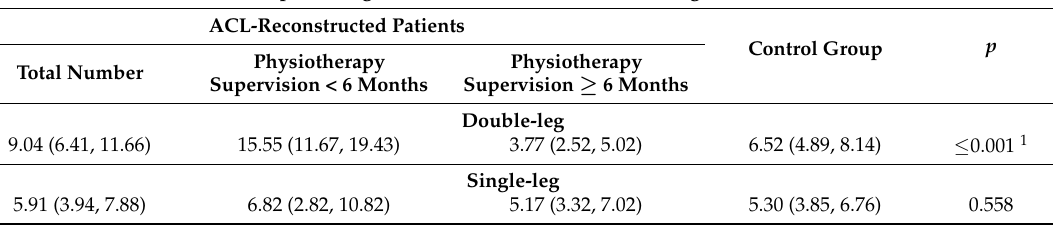
Table 4. Between-group comparison of vertical ground reaction force between-limb percentage difference values obtained during the double-leg and single-leg vertical hop landing in patients with postoperative physiotherapy supervision < 6 months, patients with postoperative physiotherapy supervision ≥ 6 months, and the control group; ACL: anterior cruciate ligament; p , level of significance of the between-group difference; vGRF BM: vertical ground reaction force normalized to body mass. Values expressed as the arithmetic mean and 95% confidence